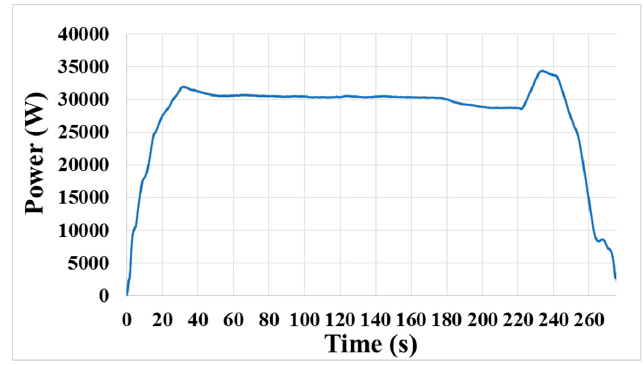
Figure 8. Smoothed motor power signal curve of the polishing platen during a CMP process.